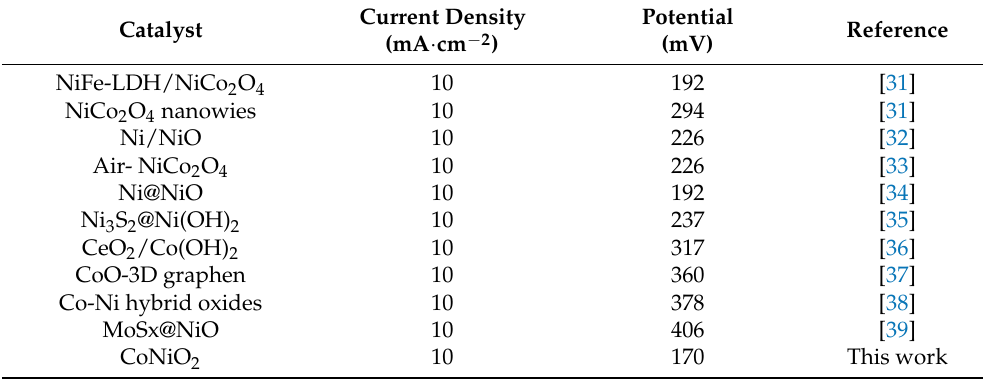
Table 1. In 1 M KOH, CoNiO 2 electrocatalyst performance in HER was compared with that of cobalt- and nickel-based